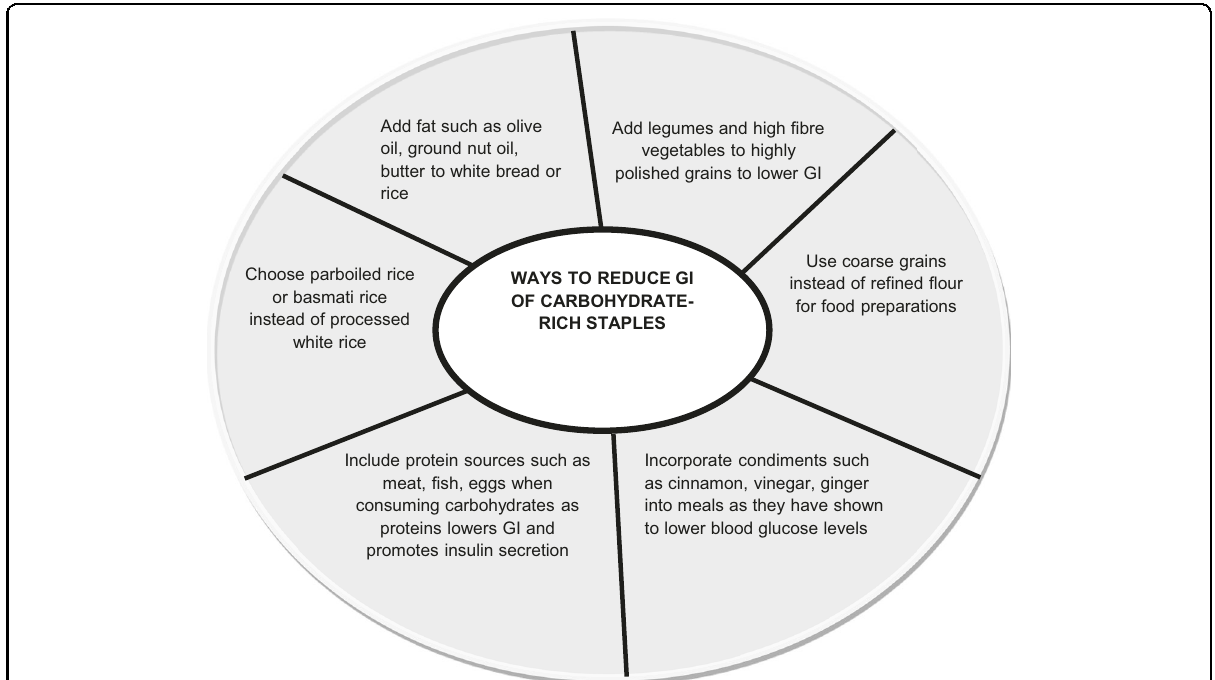
Fig. 2 Recommendations of ways to reduce the GI of carbohydrate-rich staples. Figure shows how combination of food ingredients and foods may be used to reduce the glycaemic response of rice-based